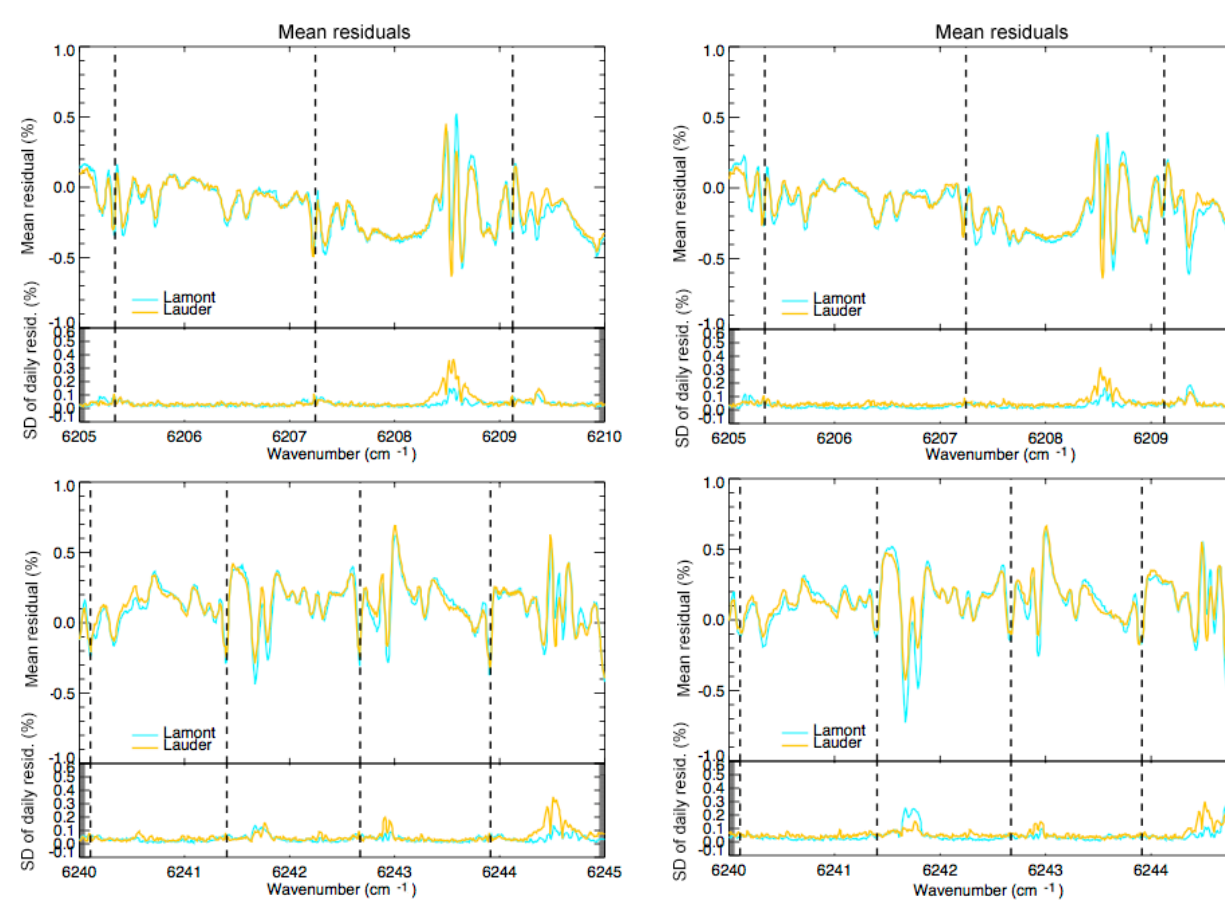
Figure 13. Mean and standard deviation of residuals in selected spectral intervals, for measurements with 2<air